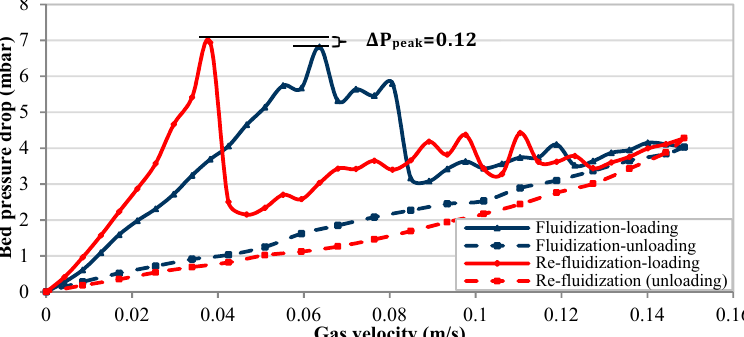
Figure 9. Fluidization and re-fluidization behaviors (after compression at 40 kPa) for a mixture of 50% of ultra-fine + 50% of fine particles.